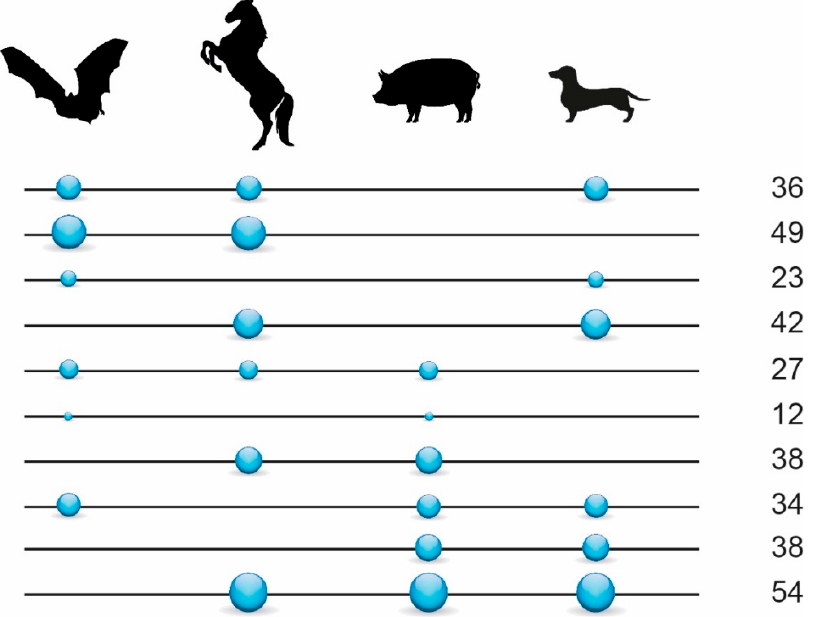
Figure 2. Retrotransposon presence/absence markers in Scrotifera. Values on the right represent the total number of informative retrotransposon insertions found for the respective interordinal affiliations as indicated by the circles (e.g., 36 shared retrotransposons for Chiroptera, Perissodactyla, and Carnivora). Circles on lines represent the presence states of retrotransposons, and the lines without circles represent the absence states. The size of the circles reflects the relative number of diagnostic markers. We used only 353 markers diagnostic for Scrotifera (from 470 in total) for the 4-LIN analysis (represented in the figure).